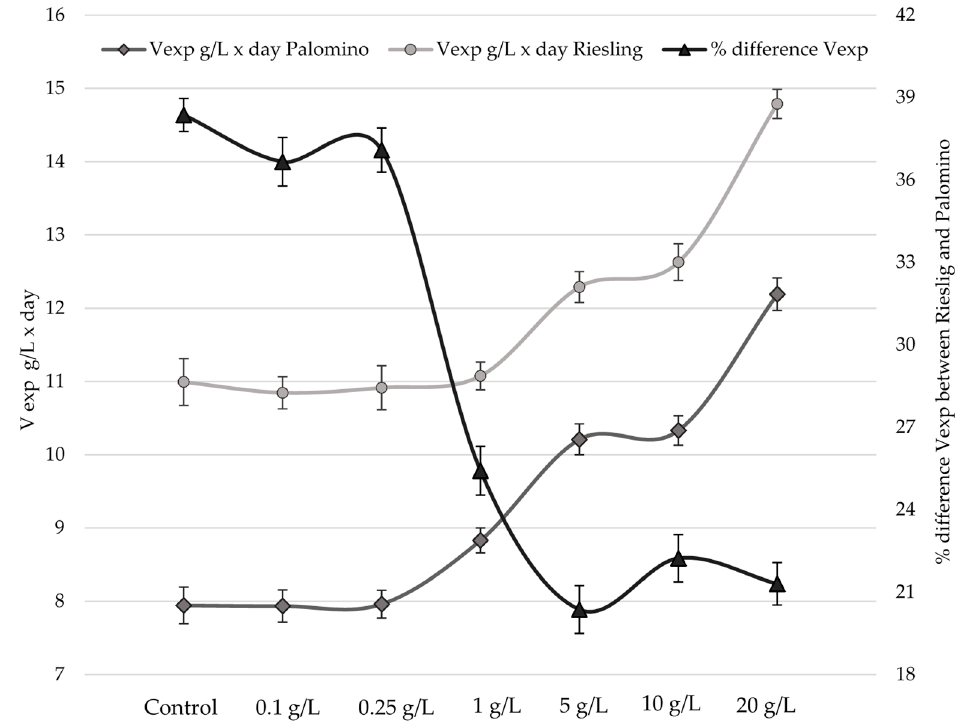
Figure 2. Fermentation rate in the exponential phase (V exp ).